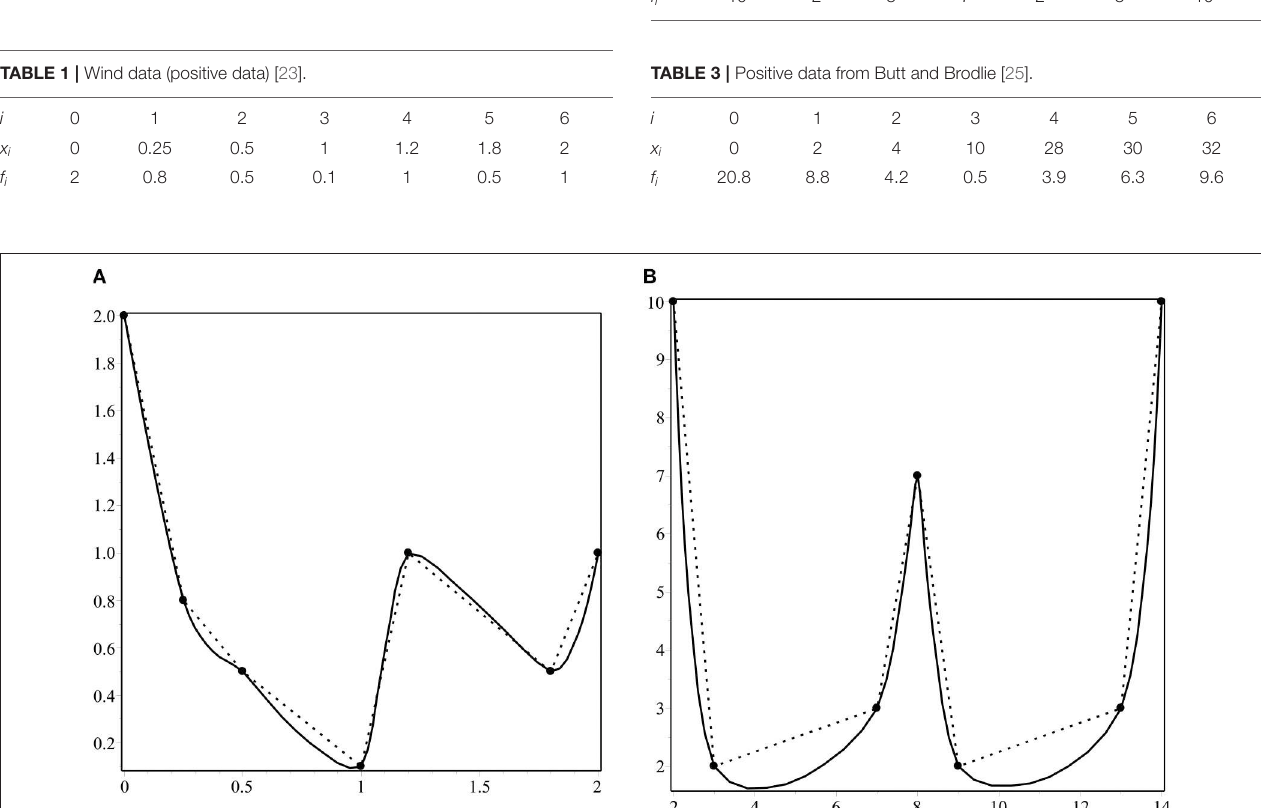
Frontiers in Physics |